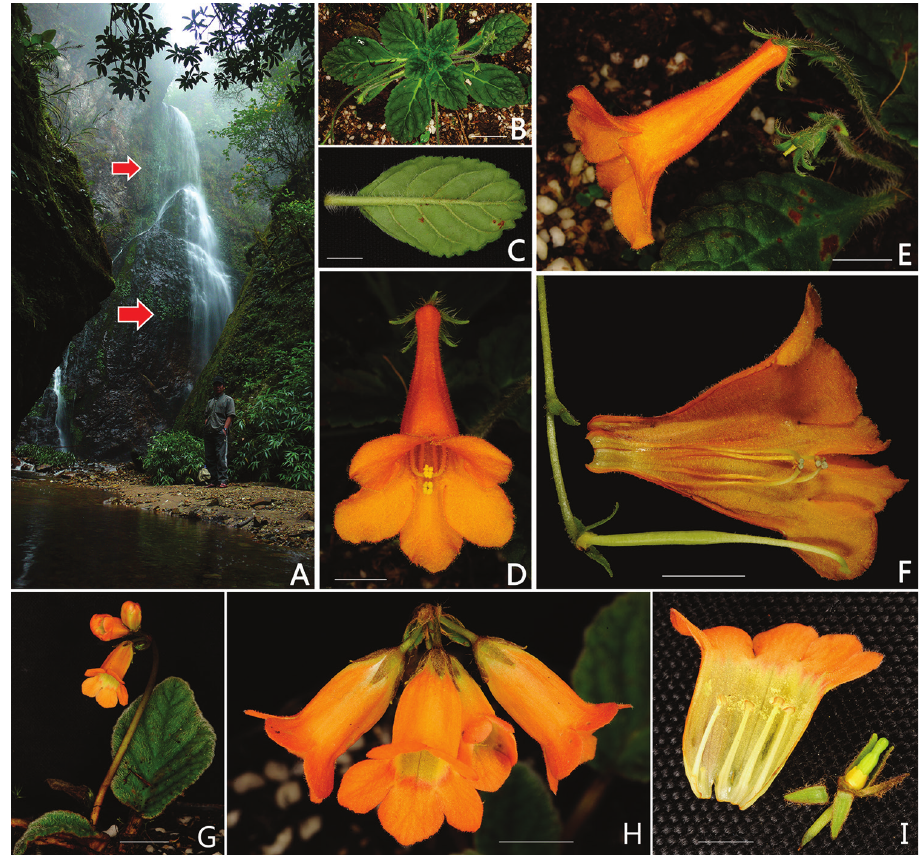
Figure 1. Oreocharis grandiflora W.H.Chen, Q.H.Nguyen & Y.M.Shui, sp. nov. ( A–F ) and O. flavida Merr. ( G–I ) A Habitat (red arrows indicate position of plants in the field) B Mature plant C Abaxial leaf surface D Front view of flower E Lateral view of flower F Opened corolla, pistil, disc and calyx G Plant H Inflorescence and open flowers I Dissected flower, showing corolla with free anthers, pistil, disc and calyx. Scale bars: A, C–F = 1 cm; B,G = 2 cm; H, I = 5 mm. All photographs by Yu-Min